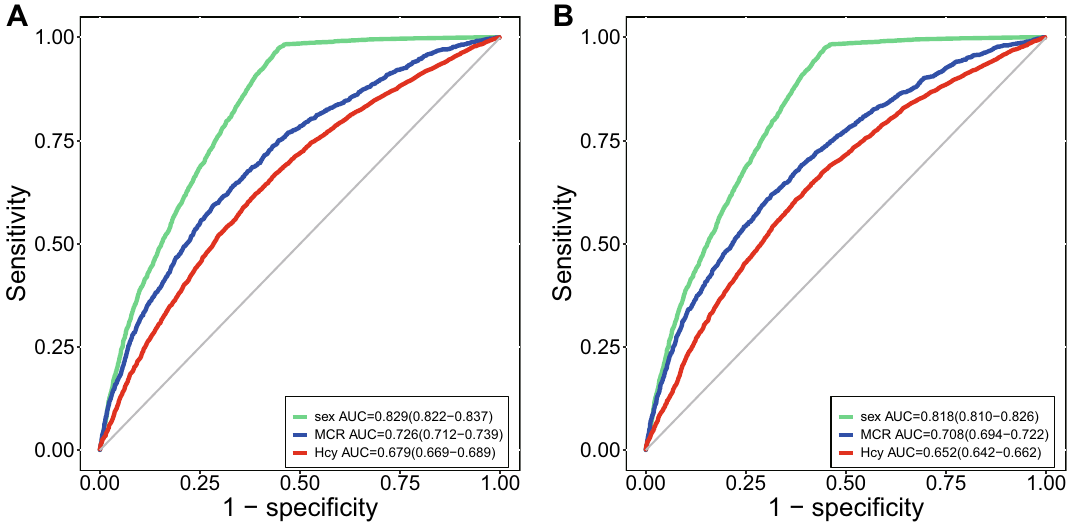
Figure 3. Performance of the Tabu-search algorithm (A) and Hill-climbing algorithm (B) in discussing risk factors for HHcy. The figures were plotted using R software (https:// www.r- proje ct.